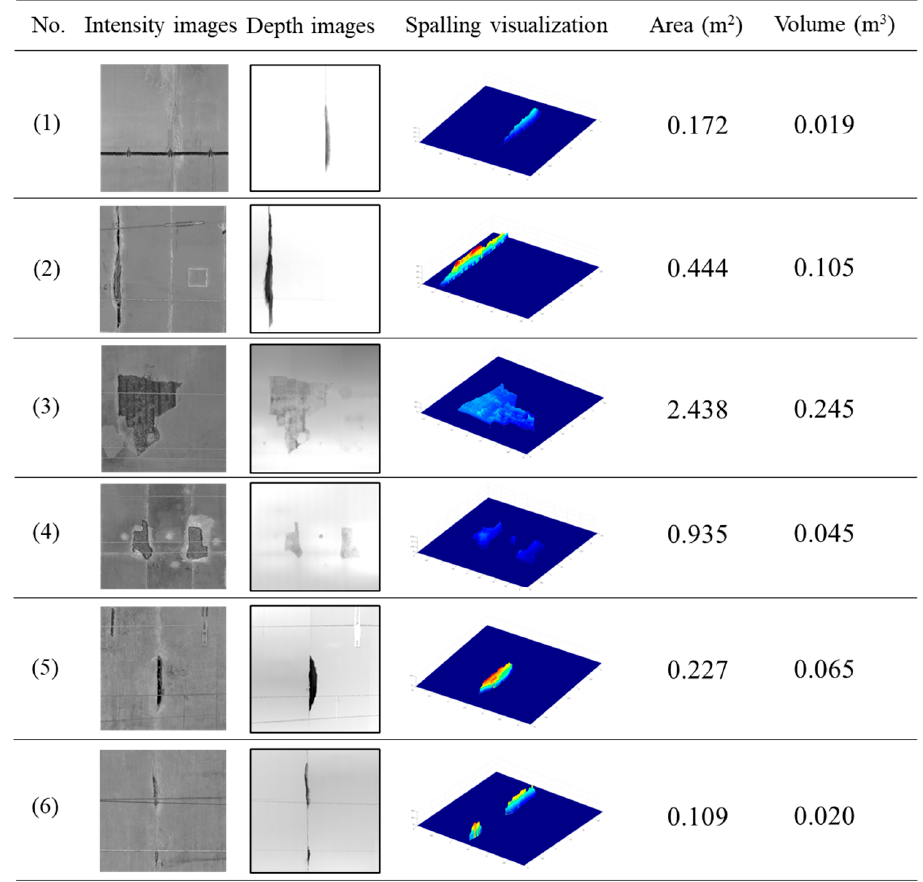
Figure 14. Detection and quantification results of six test samples.